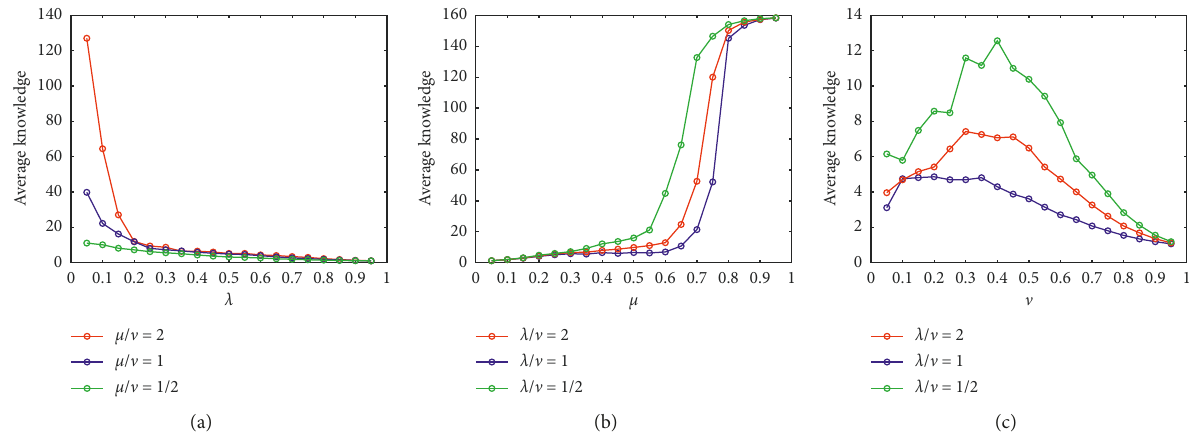
Figure 7: Influence of evolution process parameters λ , μ , and ] on the steady state of R&D network